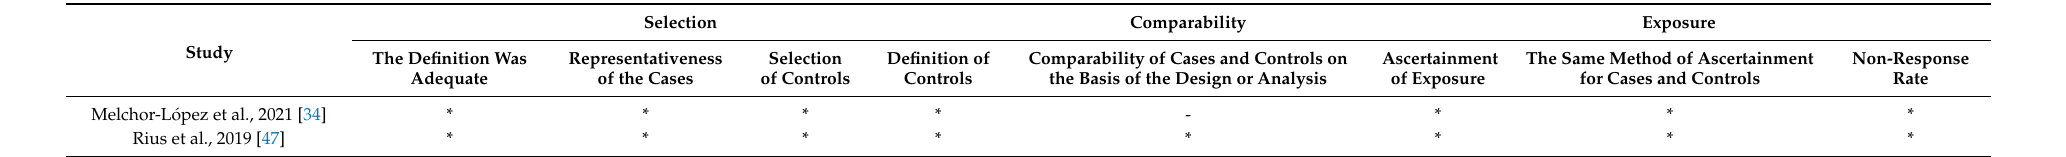
Table 3. Quality of bias assessment of the included publication in accordance with the Newcastle–Ottawa scale (case-control